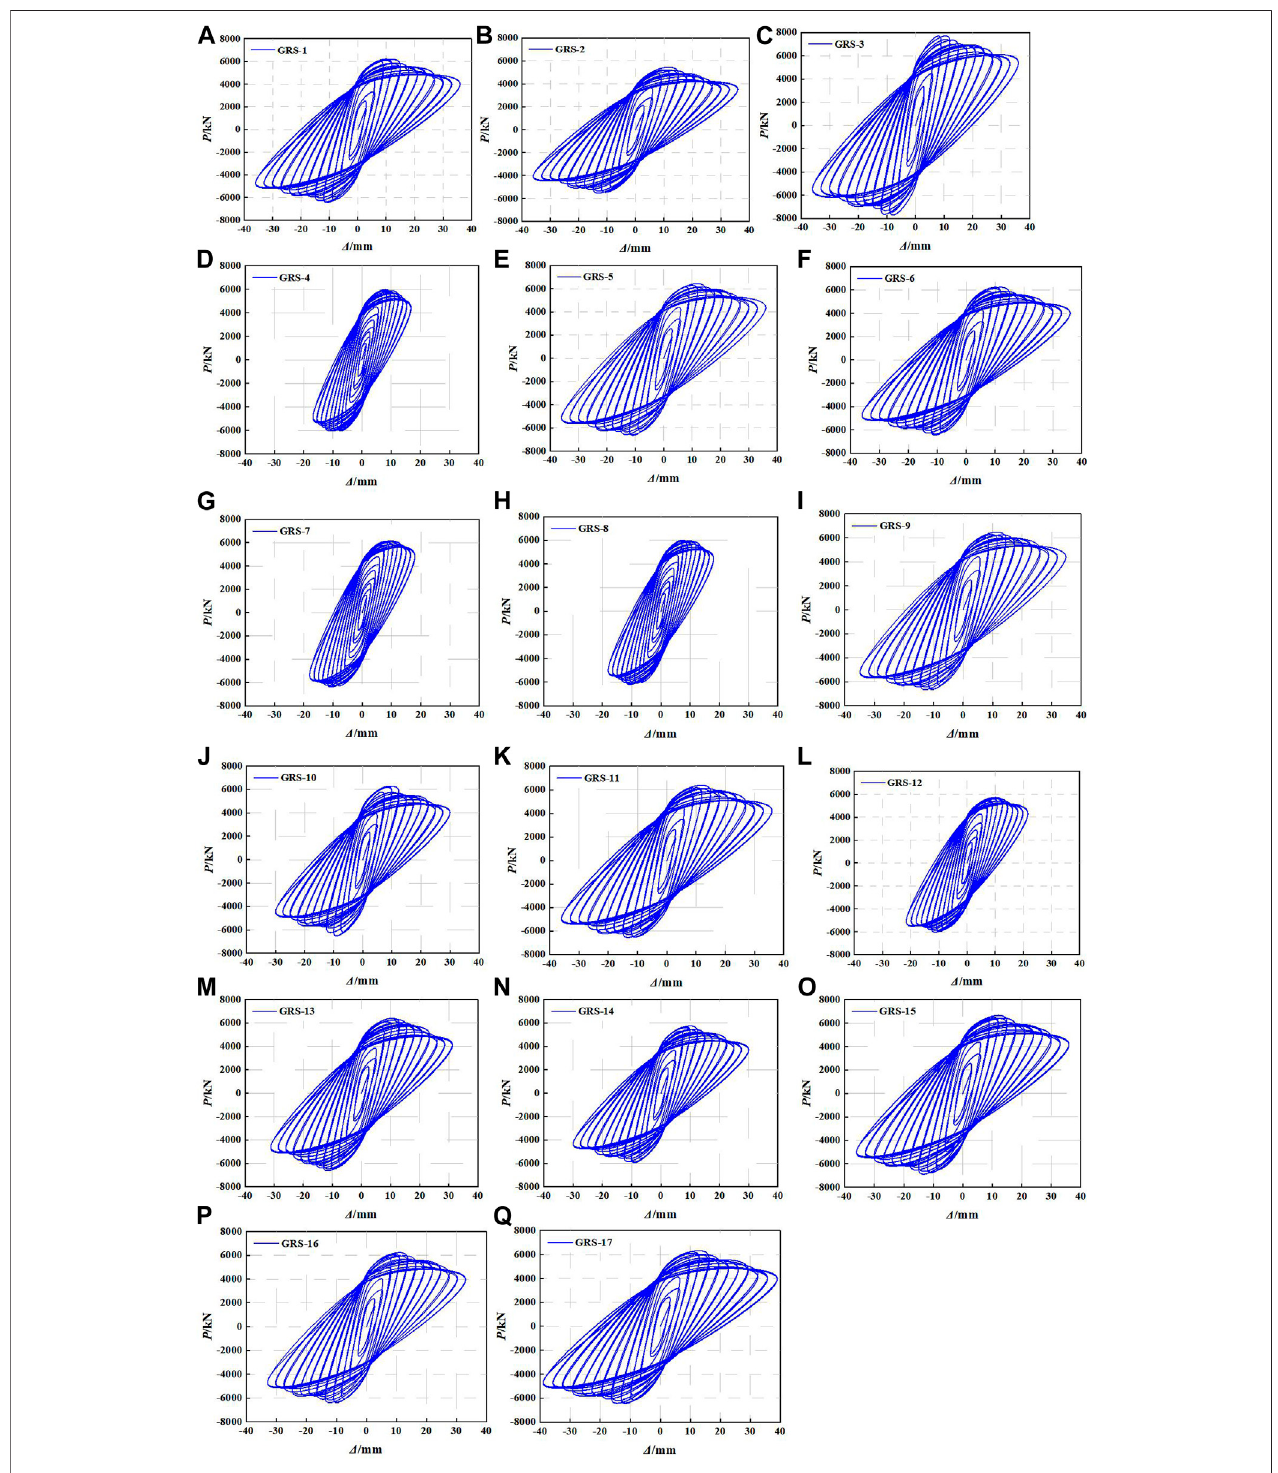
FIGURE10| Thehystereticcurvesobtainedbysimulation: (A) GRS-1; (B) GRS-2; (C) GRS-3; (D) GRS-4; (E) GRS-5; (F) GRS-6; (G) GRS-7; (H) GRS-8; (I) GRS- 9; (J) GRS-10; (K) GRS-11; (L) GRS-12; (M) GRS-13; (N) GRS-14; (O) GRS-15; (P) GRS-16; and (Q) GRS-17.